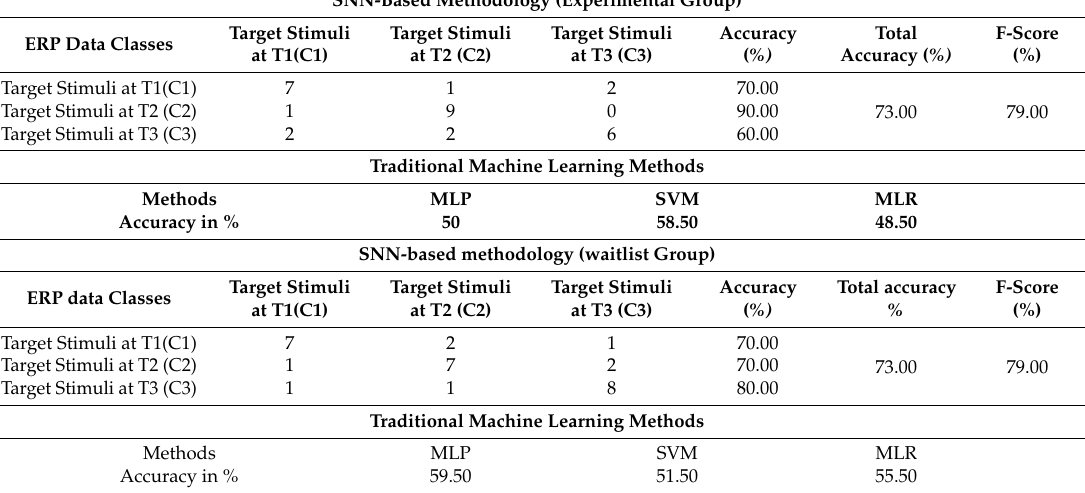
Table 3. Classification of 30 EEG samples (10 samples per participant) into three classes: target stimuli at T1-before mindfulness training (class 1), target stimuli at T2-after mindfulness training (class 2), and target stimuli at T3 (class 3) for experimental group and waitlist group. The classification method was leave-one-out-cross validation. The number of correctly classified samples in each class is located in the diagonal of the confusion table. The SNN-based classification accuracy was also compared with traditional methods: SVM, MLP, and